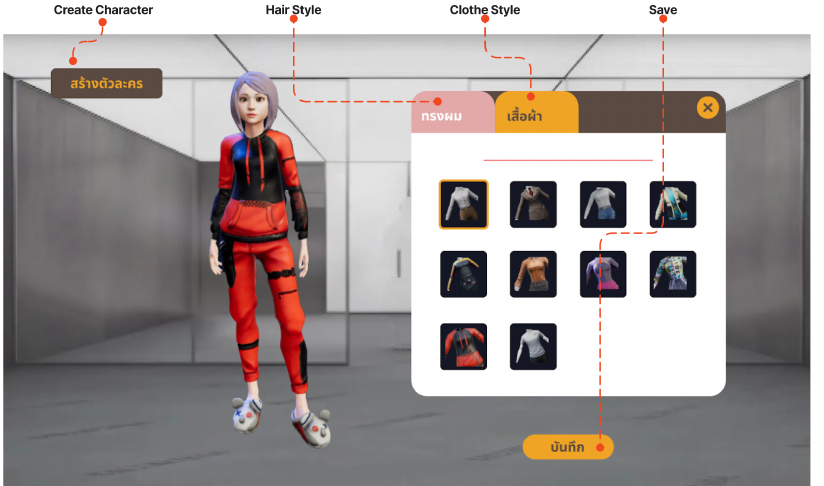
Figure 4. The platform offers customisable avatar configurations, which are implemented using a set of Ready Player Me avatars and outfits. The ’Create Character’ label is displayed on the top left. The user can customise their character with ’Hair Style’ and ’Clothe Style’. The customised character can be saved using the ’Save’ button on the lower